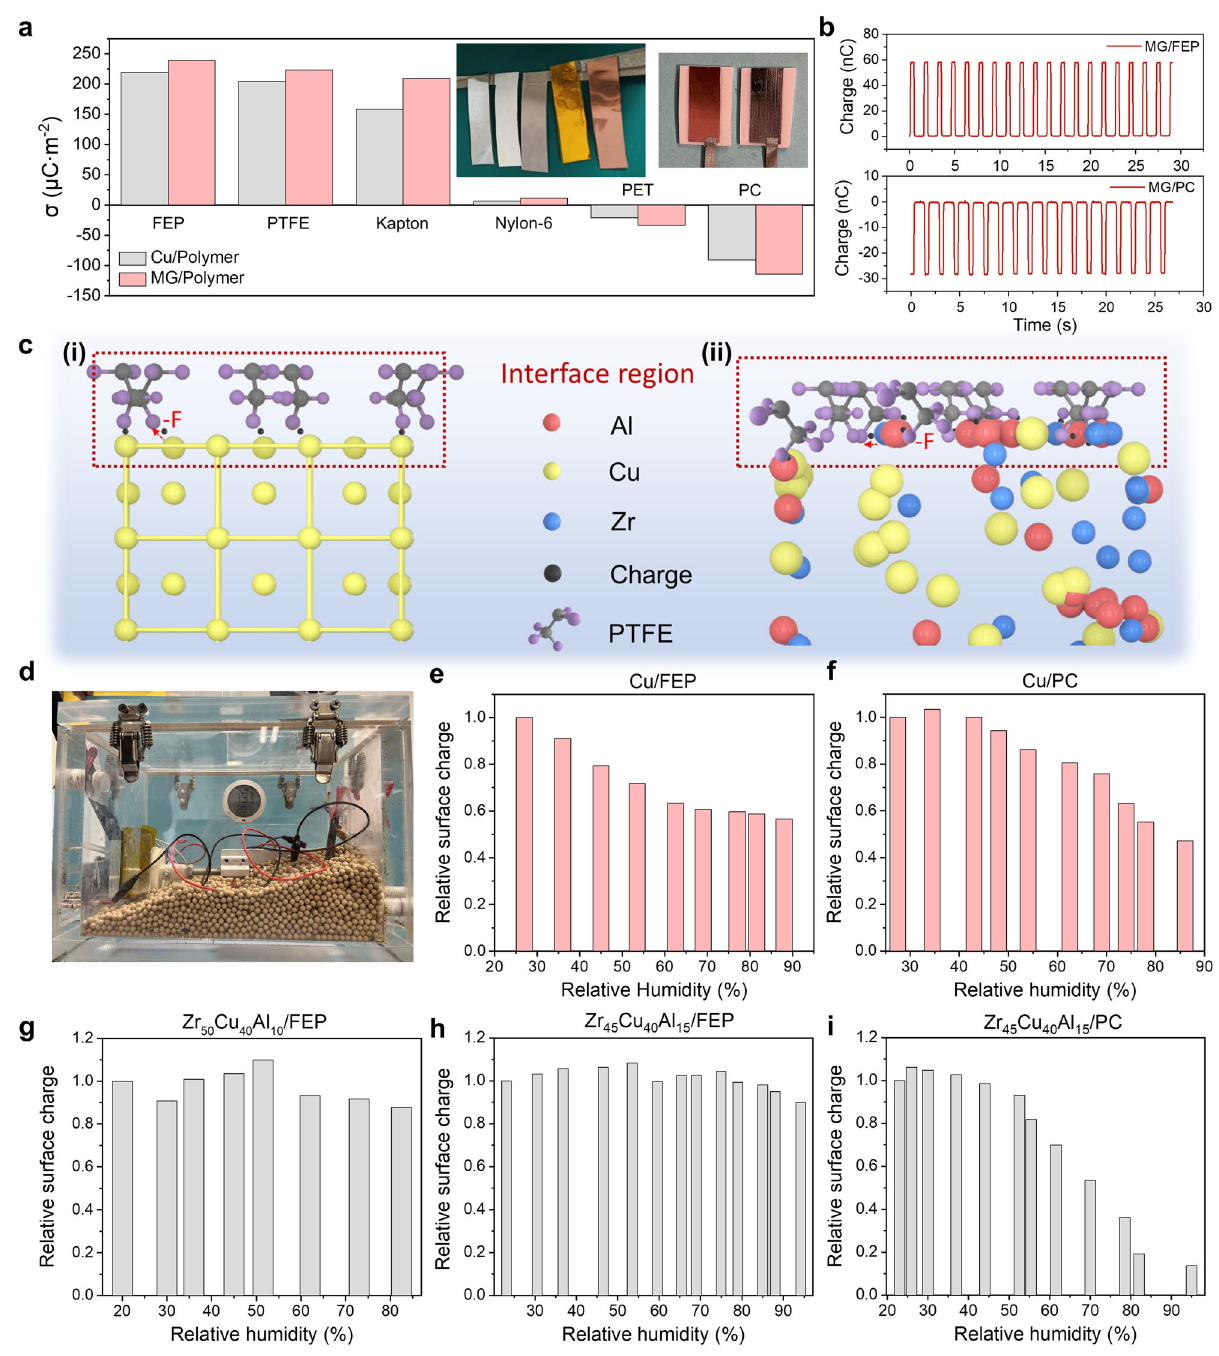
d Photograph of the experimental platform for evaluating the effect of relative humidity.Relative surfacecharge of e Cu/FEPpairand f Cu/PC pairunderdifferent relative humidity. Relative surface charge of g Zr 50 Cu 40 Al 10 /FEP pair, h